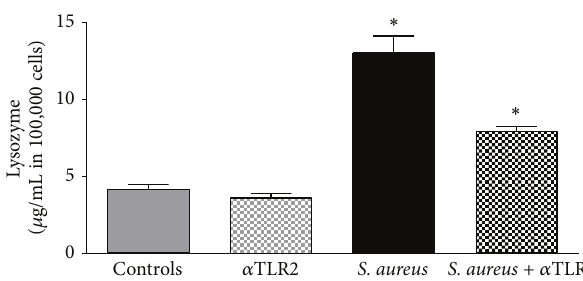
Figure 6: TLR2, a pathway for lysozyme induction . The induction of lysozyme in HepG2 cells was measured by ELISA after blocking TLR2 without stimulation, after stimulation with S. aureus, and after stimulation with S. aureus and additional blocking of TLR2. Stimulation with S. aureus and stimulation with S. aureus after blocking of TLR2 showed significant